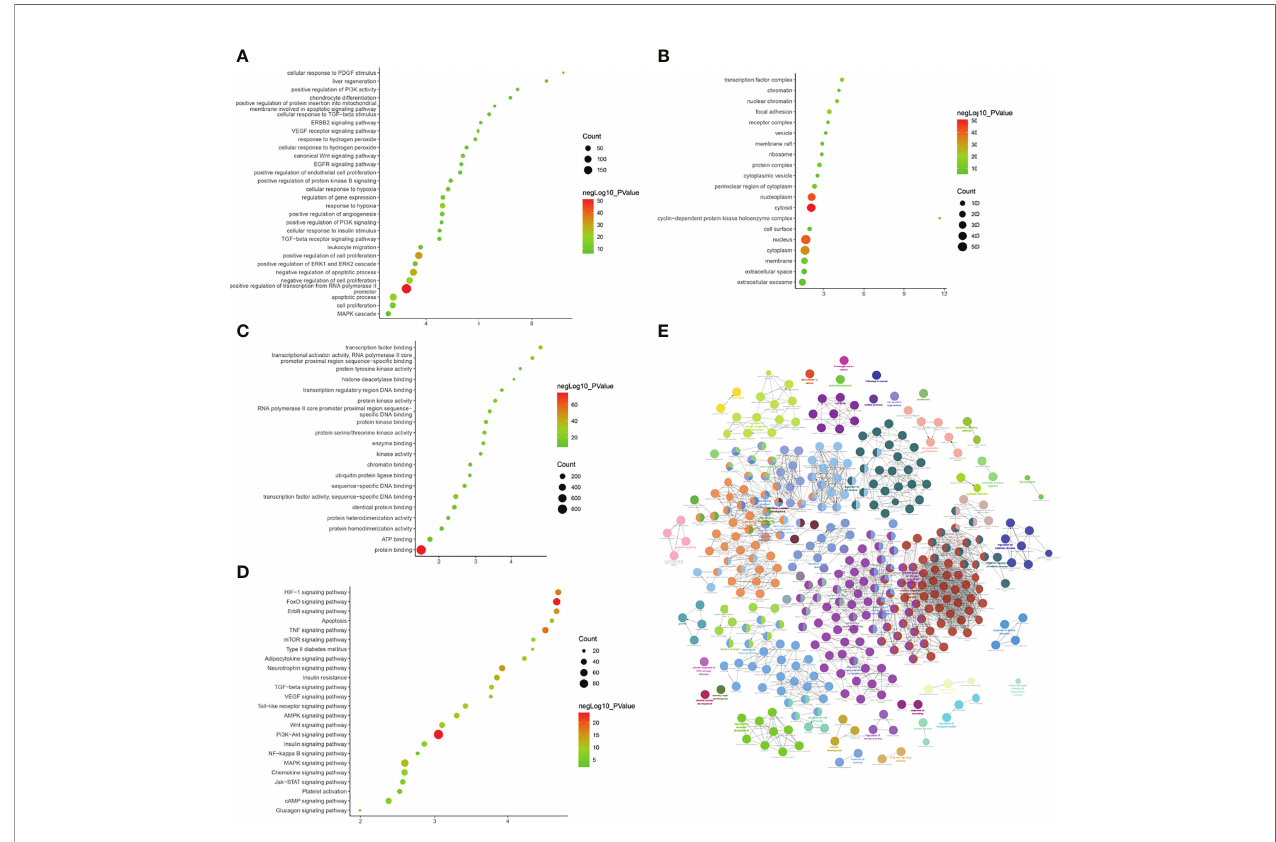
FIGURE 10 | Enrichment Analysis of lncRNA [ (A) biological processes; (B) cell components; (C) molecular functions; X-axis stands for fold enrichment. (D) Signaling pathway; X-axis stands for enrichment score. (E) Enrichment